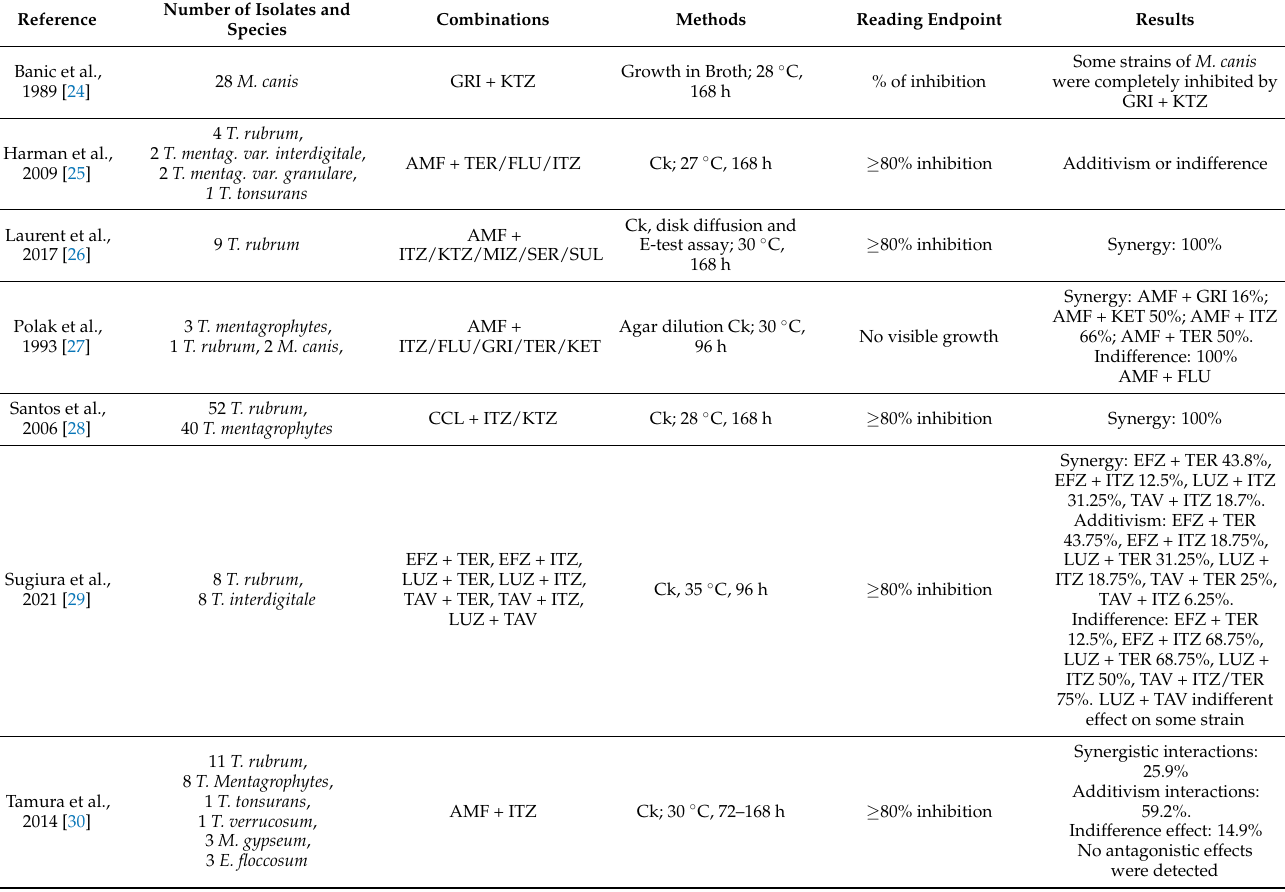
Table 1. Antifungal combinations against dermatophytes: in vitro effects of antifungal plus